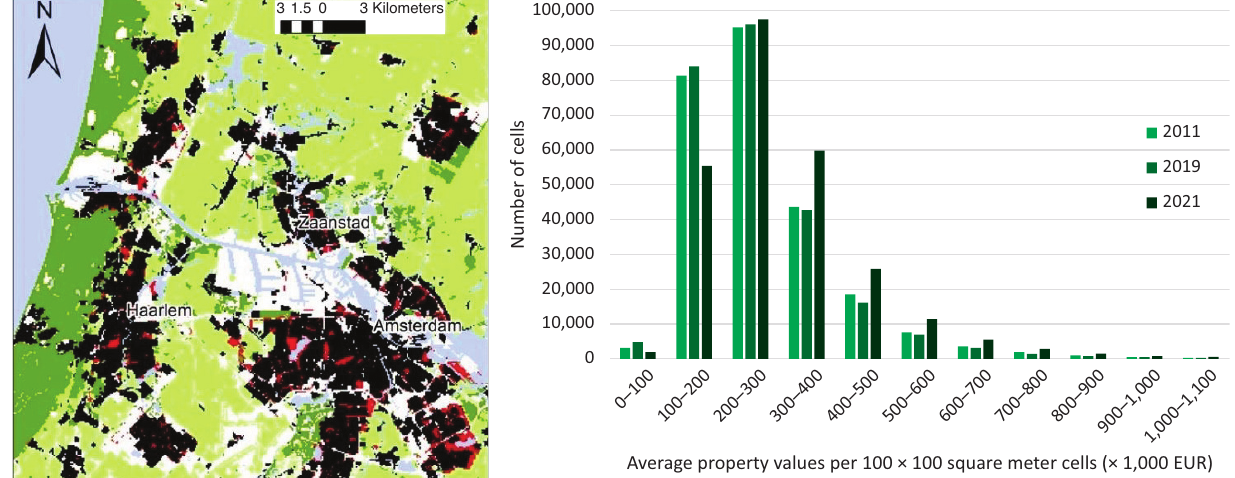
Figure 2. On the left are the main categories of land use in the Amsterdam area (residential areas in black, urban parks in red, nature in dark green, and agriculture in light green); on the right is a histogram with the distribution of the residential values per cell in the country. Note: The graph is trimmed to the right since the distribution has a long tail, with few cells that have extremely high residential values, beyond